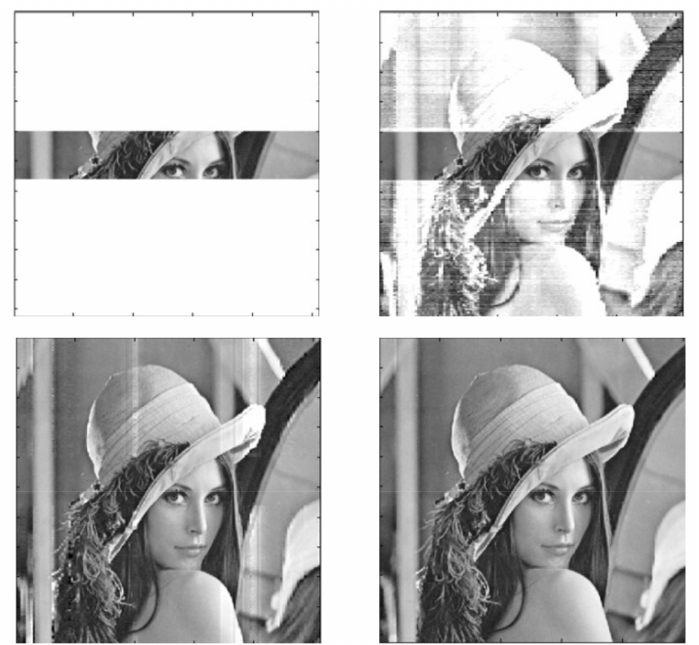
Figure 9. Image reconstruction of Lena’s photo (reconstruction system in Figure 7).